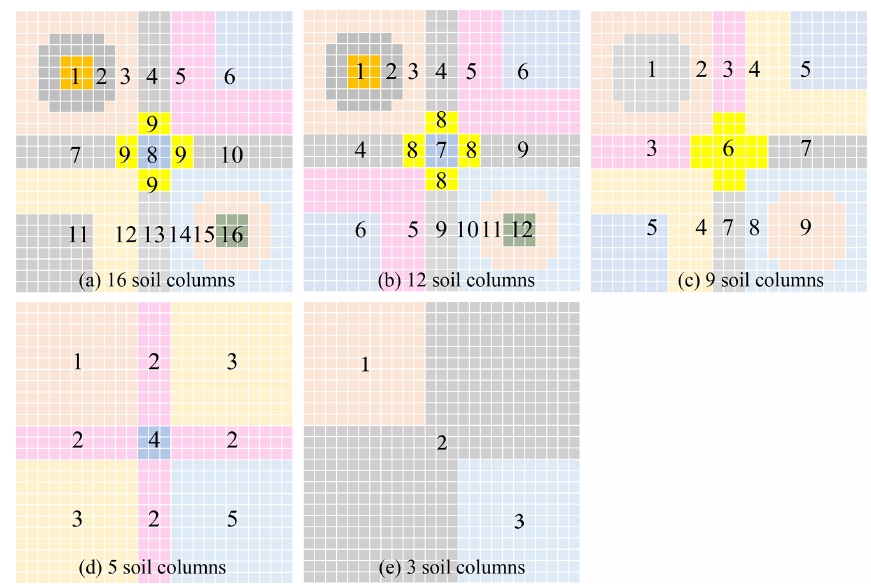
Figure 5. Different number of subzones partitioned for the quasi-3-D simulations in case 3. The vadose zone is partitioned into 16, 12, 9, 5, and 3